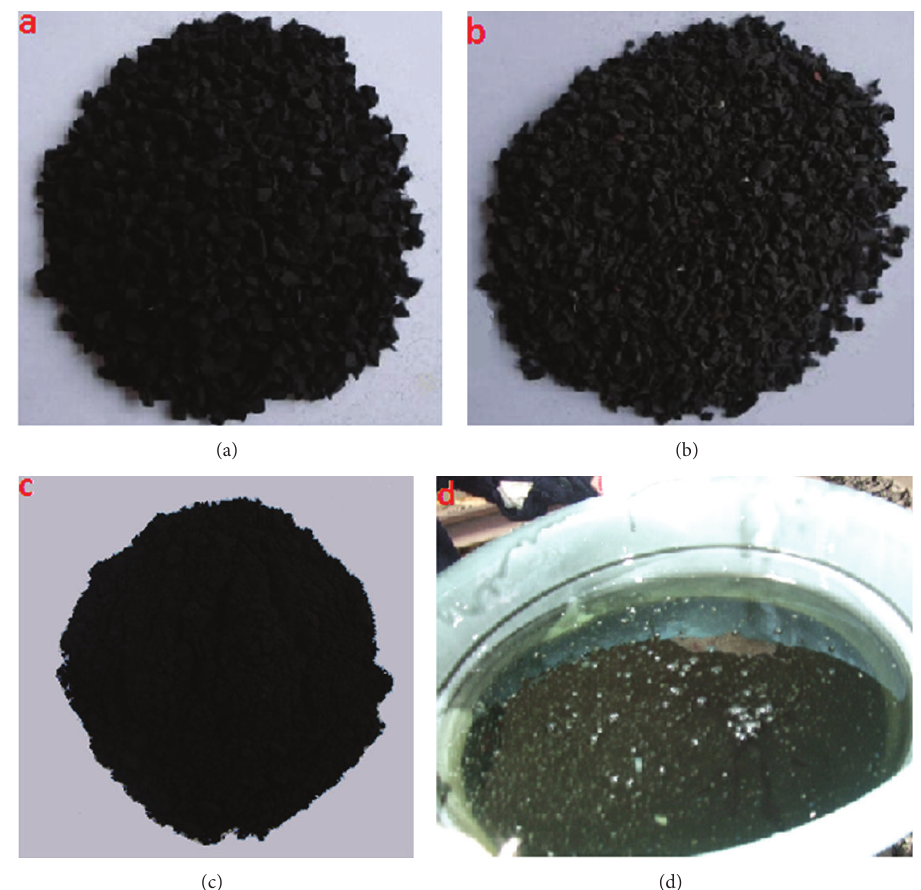
Figure 2: Main materials of the damping chamber elements: deconstructed waste-tires particle of 4-5 mm (a) and 1–3 mm (b), carbon black (c), and polyurethane (d).